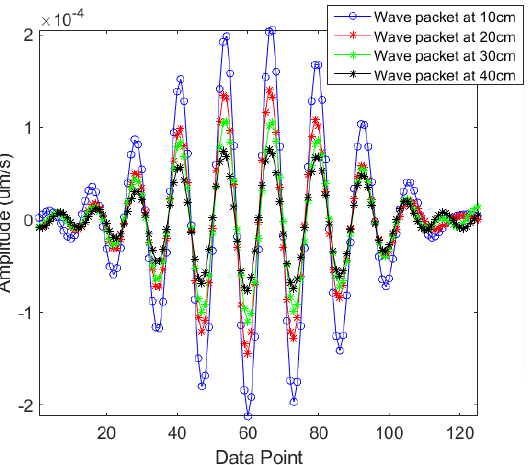
Figure 7. Wave packets of the signals measured at 10 cm, 20 cm, 30 cm and 40cm away from the excitation area.